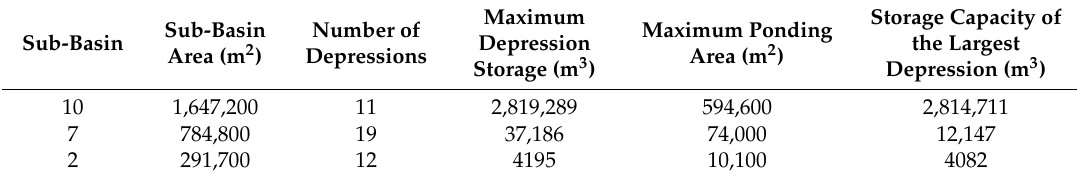
Table 3. Characteristics of depressions for three selected sub-basins (sub-basins 10, 7, and 2).